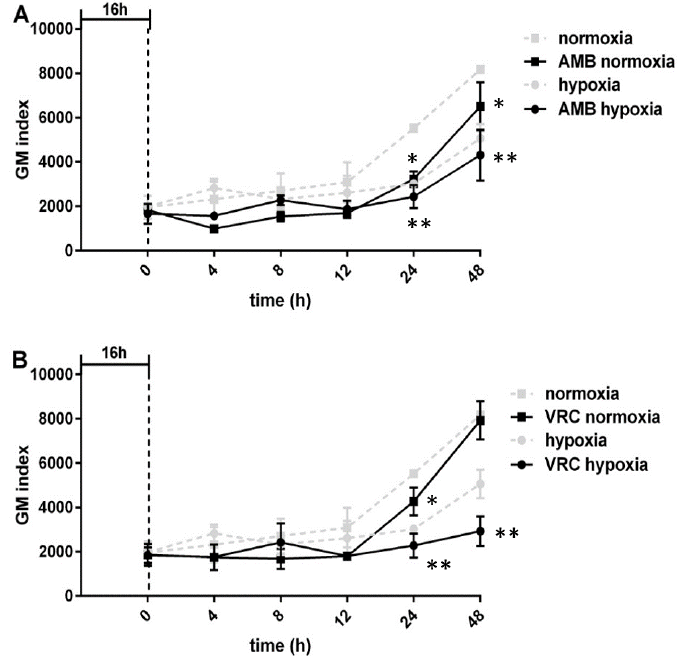
Figure 2. Kinetics of GM release by A. fumigatus indicated as an index in the absence (broken grey lines) and presence (unbroken black lines) of ( A ) AMB and ( B ) VRC under normoxic ( ■ ) and hypoxic conditions (●). Vertical lines define the shift to either normoxia or hypoxia, and subsequent addition of antifungals (16 h; nomoxic conditions). Stars (*) indicate statistically significant differences of antifungal-treated samples compared to the normoxic control: * indicates p ≤ 0.05, ** indicates p ≤ 0.005.